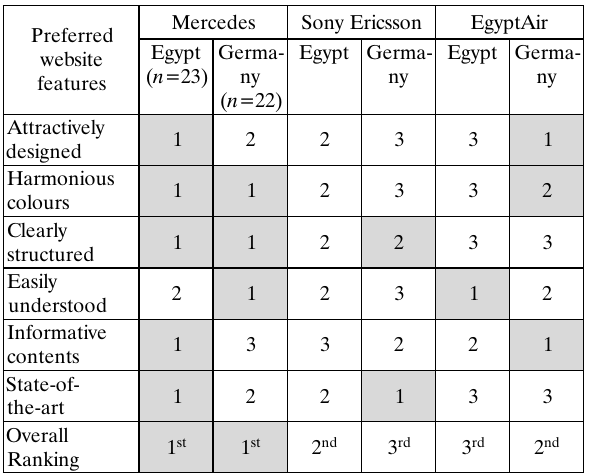
Table 2. Overall ranking of the websites researched The post-test stage comprised the analysis of the